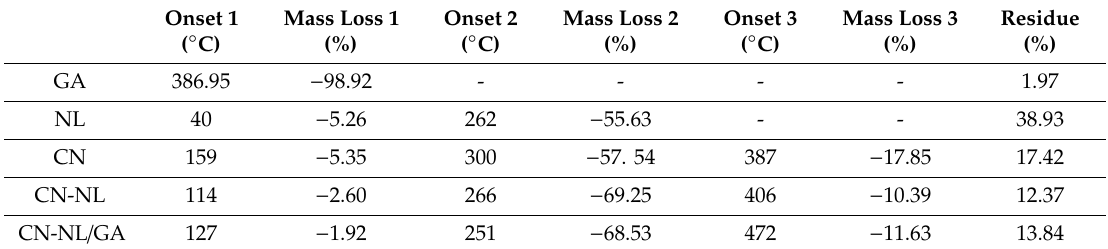
Figure 5. Thermogravimetric trends related to: ( A ) GA, NL and CN; ( B ) CN-NL and CN-NL / GA. Table 1. Results of TGA